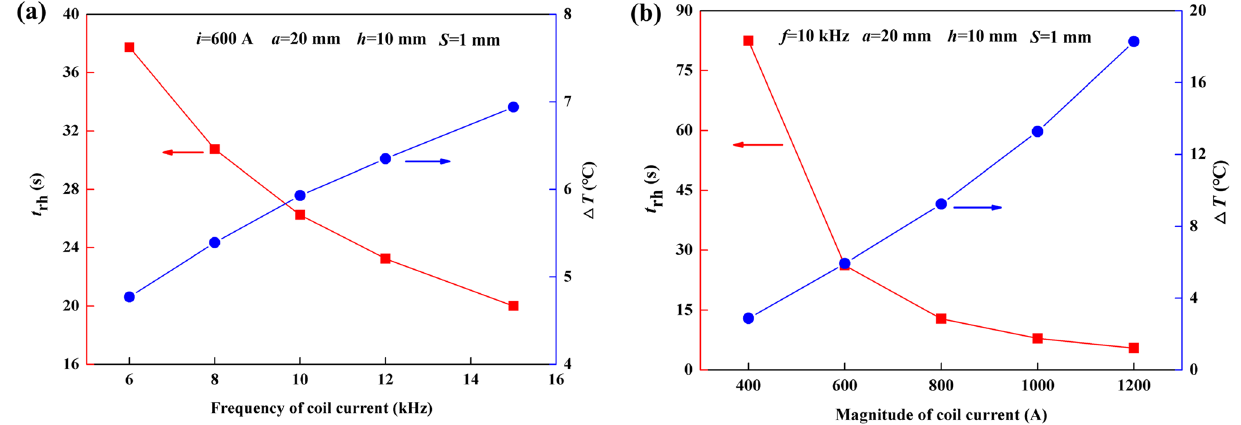
Fig. 3 Variations of t and Δ T with frequency ( a ) and magnitude ( b ) of coil current rh